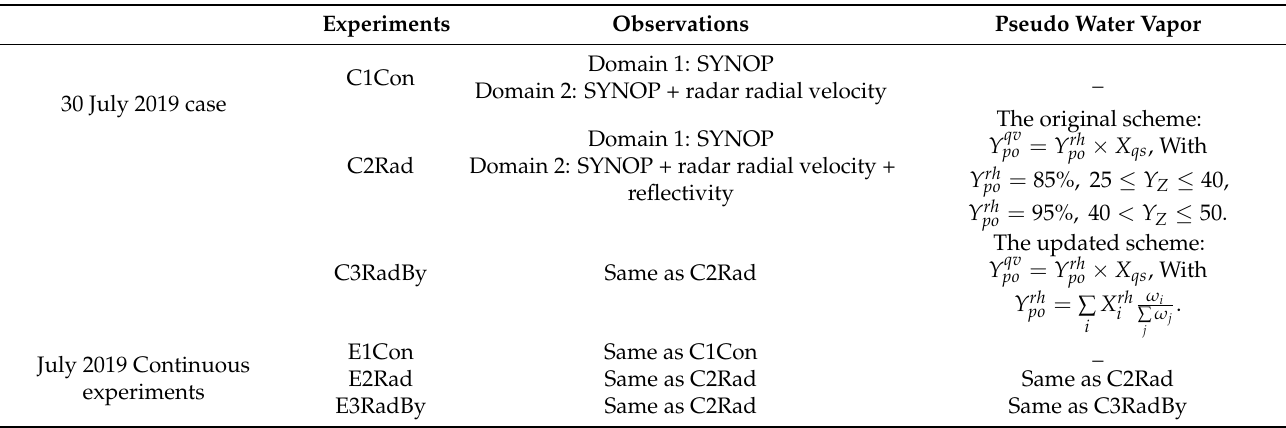
Table 2. List of